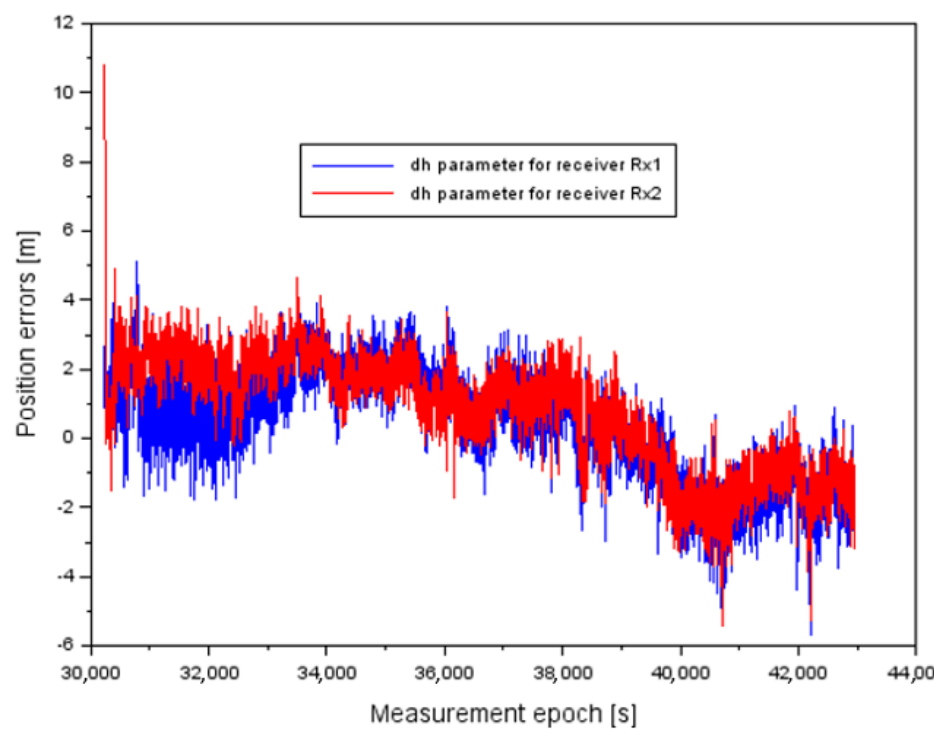
Figure 11. The results of 𝑑ℎ position errors for 𝑅𝑥1 and 𝑅𝑥2 receivers.